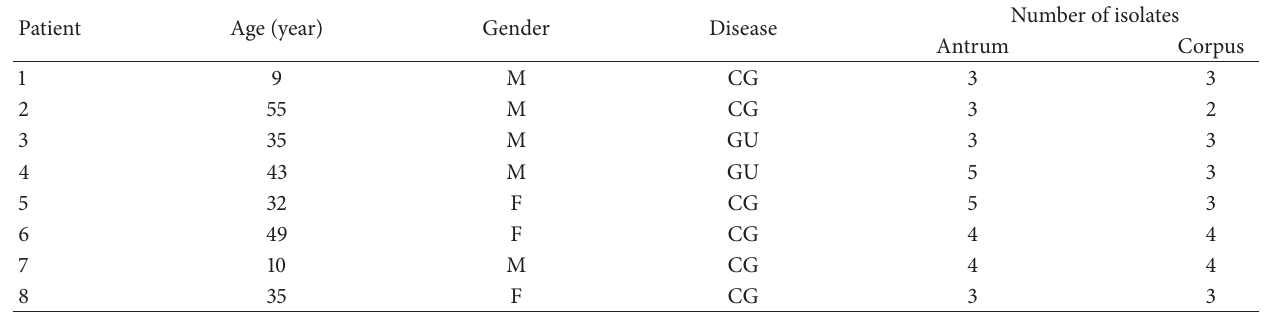
Table 3: Characteristics of patients from whom plural isolates were obtained from a biopsy specimen.